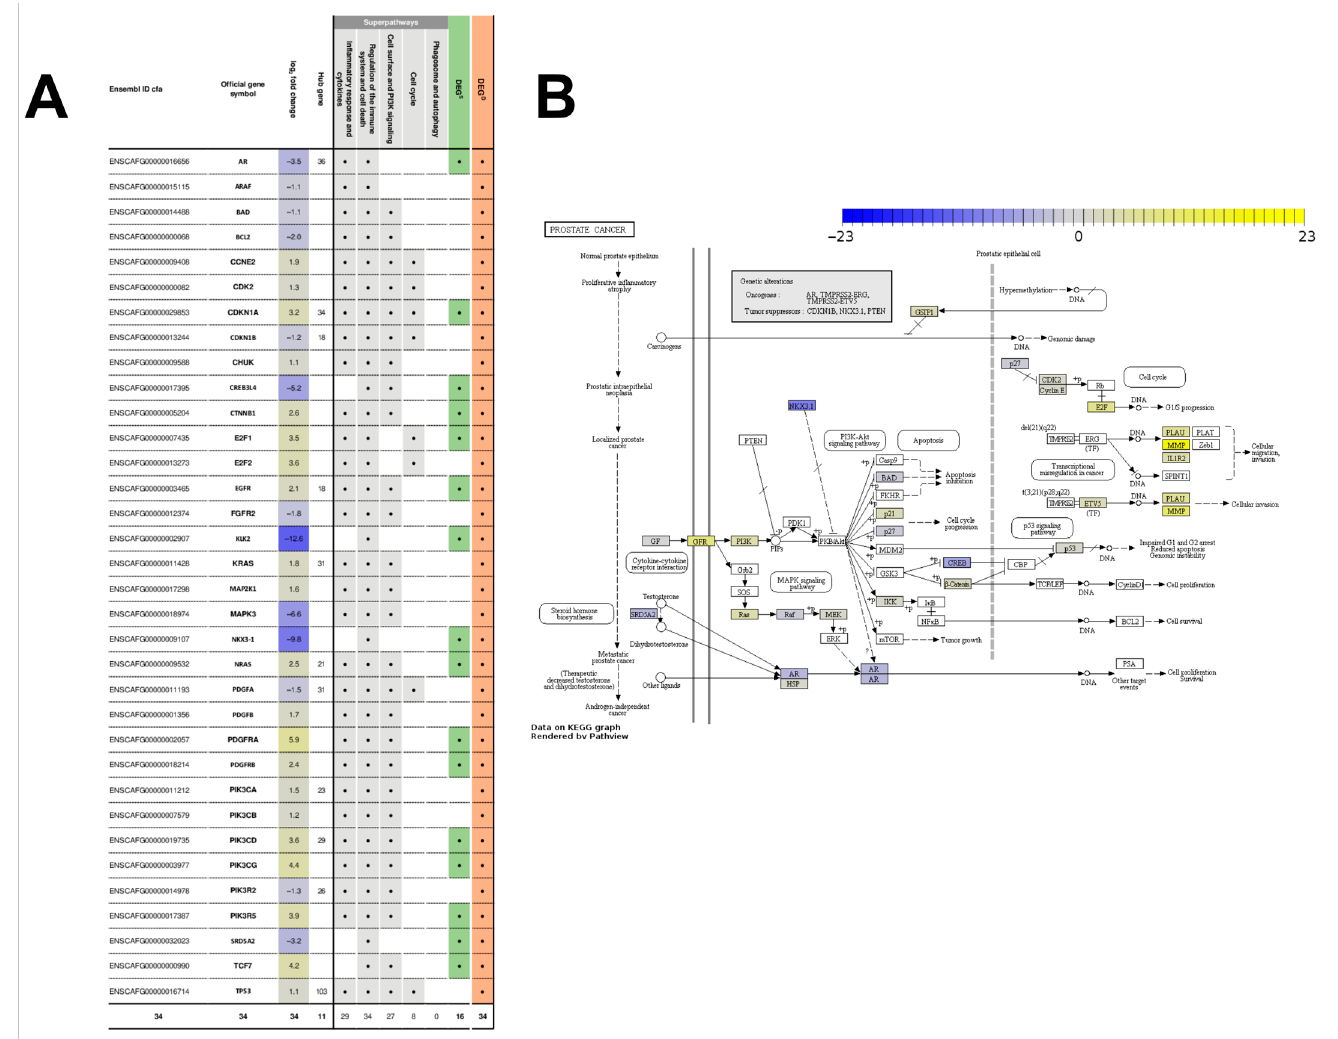
Figure 5. Prostate cancer (PCa) pathway. ( A ) Differentially expressed genes (DEGs) in the PCa pathway. Ensembl gene identifier (Ensembl ID cfa, column 1), official gene symbol (column 2), base-2 logarithm (log2) fold-change in the expression value of the genes between the nonmalignant and malignant sample groups (column 3); in columns 5 to 11, a dot indicates whether the gene is a database-associated deregulated gene (DEG D , column 11) and/or a strongly deregulated superpathway gene (DEG S , column 10), as well as whether the gene is a member of any of the five superpathways (columns 5–9): (i) inflammatory response and cytokines; (ii) regulation of the immune system and cell death; (iii) cell surface and PI3K signaling; (iv) cell cycle; and (v) phagosome and autophagy; ( B ) Modified graphic diagram of the PCa pathway (cfa05215; [40]), visualized using the Pathview Web tool [41]. Genes are represented as rectangles and molecular interactions as arrows. The color of the rectangles illustrates the log2 fold-changes of the expression value of the genes between the nonmalignant and malignant sample groups; upregulated genes are displayed in yellow; downregulated genes in blue; genes that are not deregulated are shown in gray. Protein–protein interactions: phosphorylation (+p), dephosphorylation ( − p). Additional pathways related to the PCa are highlighted as boxes with rounded corners. Related pathways that are associated with the superpathways are highlighted with green boxes with rounded corners. Discrepancies in annotations between KEGG and the database for annotation, visualization and integrated Discovery (DAVID) are highlighted with black asterisks.